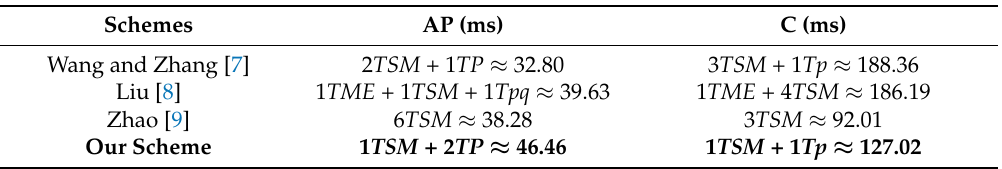
Table 4. Functioning Evaluation (Execution